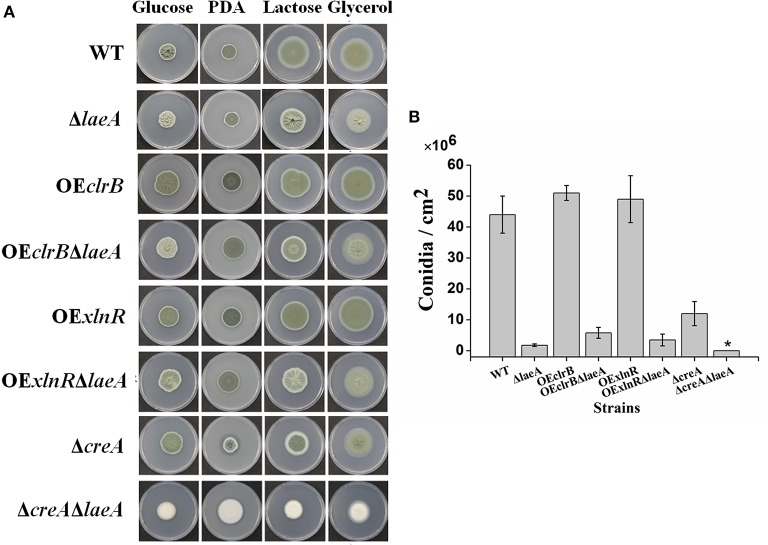
Colony morphology and conidiation of WT and various mutants. (A) Colony morphology of 4-day-old cultures on PDA or Vogel's medium agar with 2% glucose, 2% lactose, and 2% glycerol at 30°C. For WT, ΔlaeA, OEclrB, OEclrBΔlaeA, OExlnR, OExlnRΔlaeA, and ΔcreA, 1 μL conidia solution was dropped onto the agar at a density of 106 conidia mL−1. For ΔlaeAΔcreA, 1 μL of hyphal fragment solution was dropped onto the agar because it could not generate conidia. (B) Levels of conidiation on Vogel's medium agar with 2% glucose. Plates were incubated at 30°C for 4 days, and 5-mm diameter colony agar plugs in triplicate were sampled for each strain. The number of conidia was determined by using a hemocytometer. *, no conidia were observed.